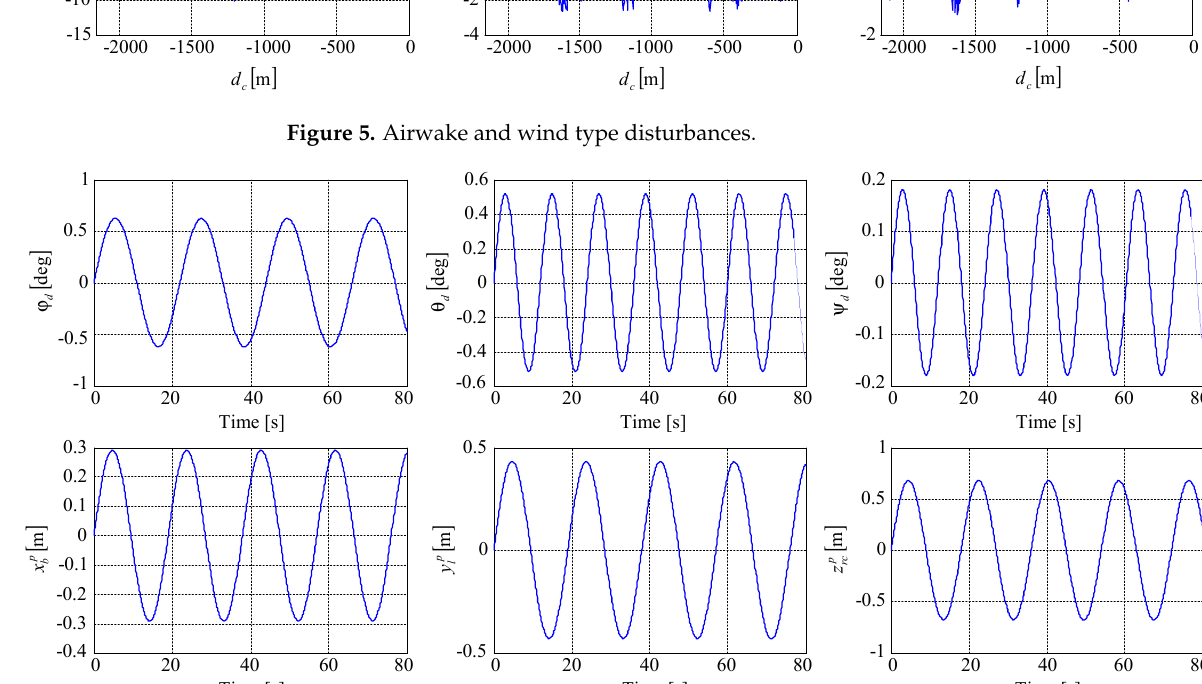
Figure 6. Rotational and translation dynamics of the carrier deck.